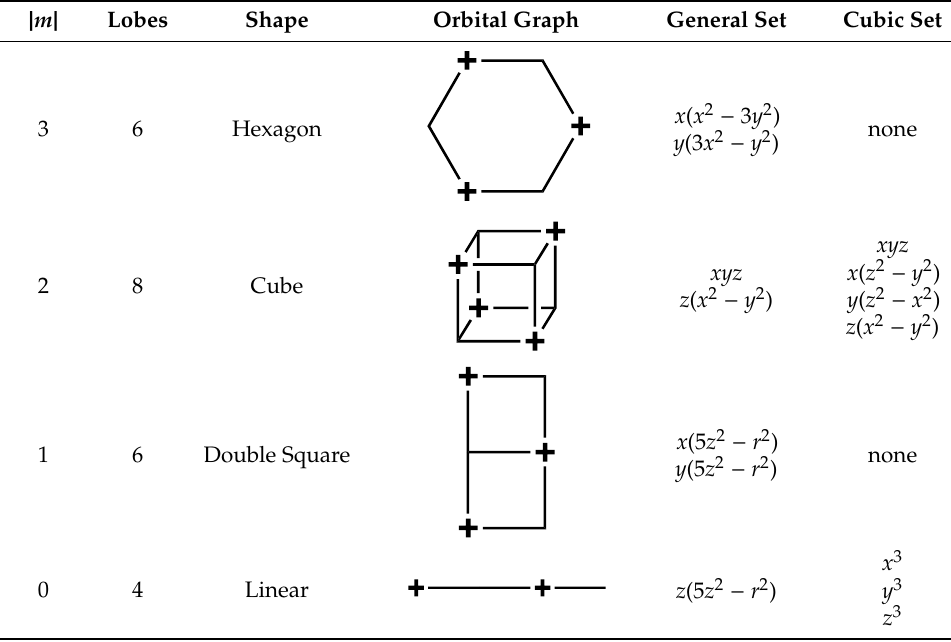
Table 2. The polynomials, angular functions, and orbital graphs for both the general and cubic sets of the seven f orbitals.